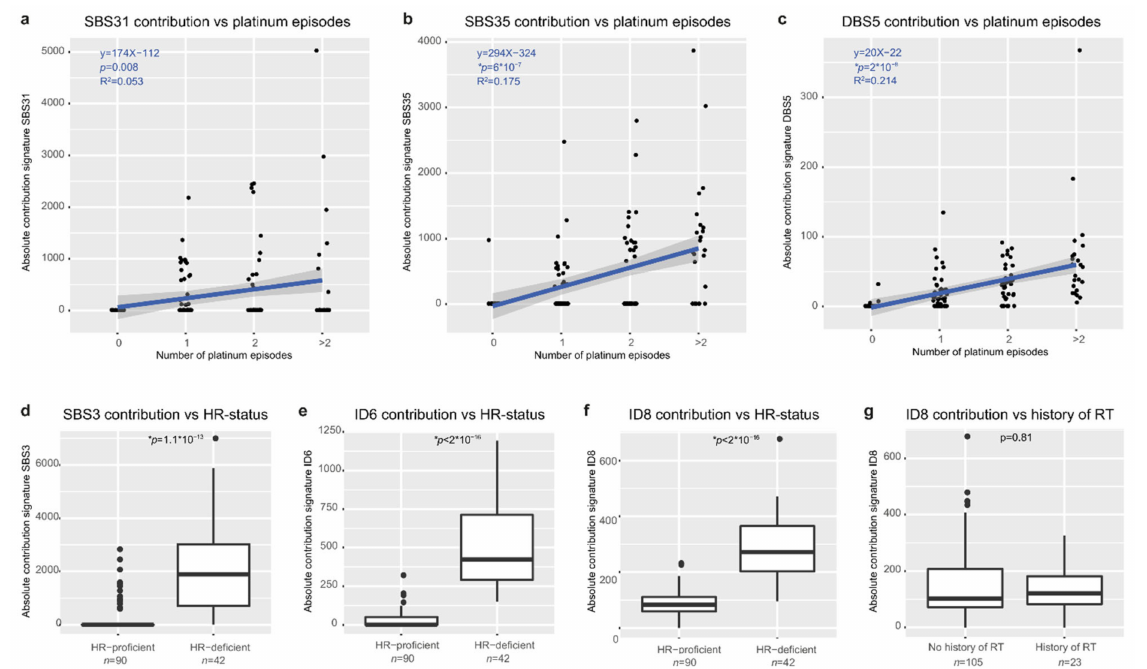
Figure 3. Mutational signatures reflect treatment history and endogenous processes. ( a – c ) The absolute contribution of SBS31 ( a ), SBS35 ( b ), and DBS5 ( c ) correlates with increasing platinum exposure. One platinum episode includes multiple platinum cycles. ( d – f ) The absolute contribution of SBS3 ( d ), ID6 ( e ), and ID8 ( f ) is significantly increased in patients with HR-deficient tumors. HR deficiency is classified by CHORD. ( g ) The absolute contribution to ID8 is not related to exposure to ionizing radiation therapy ( p = 0.81). * p -value < 0.007 indicated statistical significance (after Bonferroni correction), Wilcoxon signed-rank